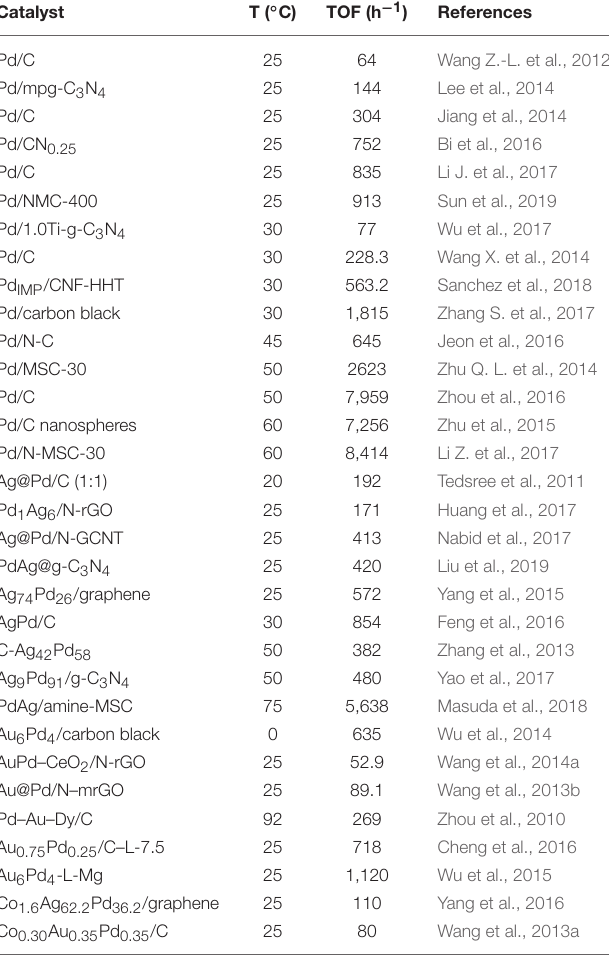
TABLE 1 | Representative catalysts based on carbon materials used in the formic acid dehydrogenation reaction.